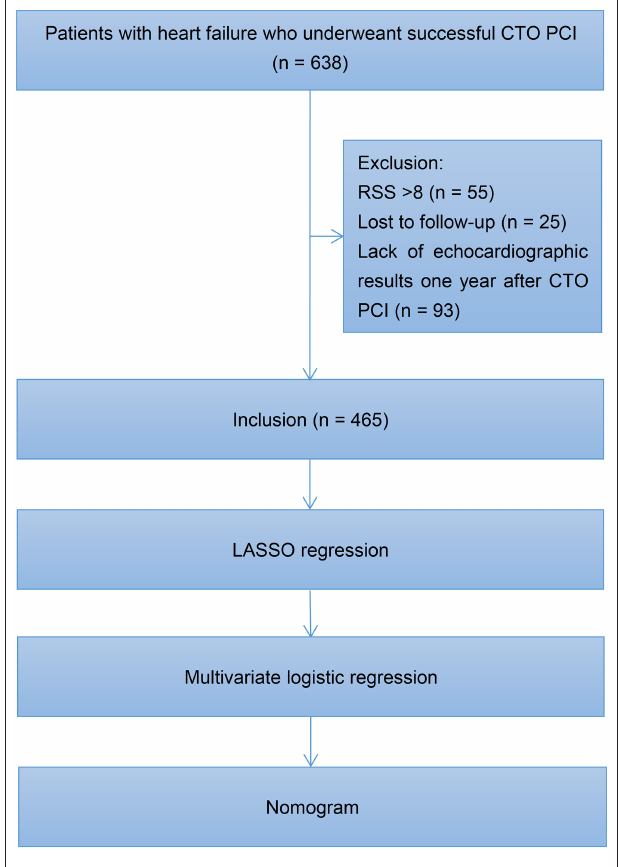
FIGURE 1 | Study flowchart. CTO, chronic total occlusion; PCI, percutaneous coronary intervention; RSS, residual Synergy Between Percutaneous Coronary Intervention with Taxus and Cardiac Surgery score; LASSO, least absolute shrinkage and selection operator.